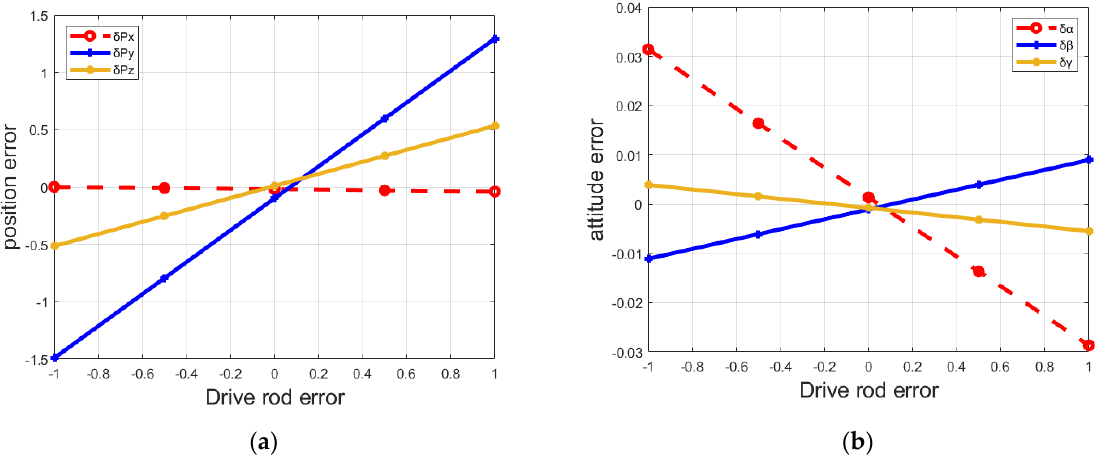
Figure 4. Influence of drive rod 1 error on FRR end-effector pose error: ( a ) drive rod 1 error on positional error; ( b ) drive rod 1 error on attitude error.